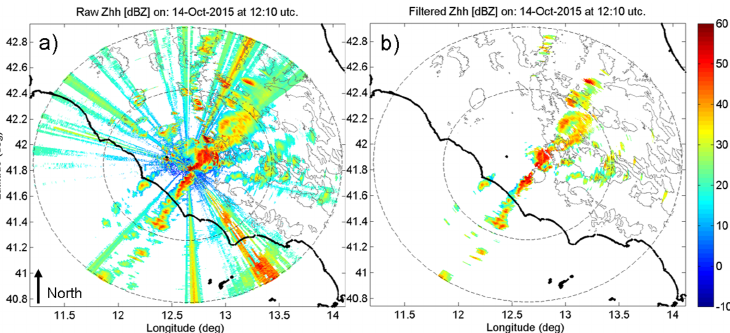
Figure A1. Example of the outcome of the clutter filtering procedure on 14 October 2015 at 12:10 UTC for a Plan Position Indicator (PPI) at 1.59 deg radar antenna elevation. ( a ) Raw reflectivity factor, Z hh , (dBZ); ( b ) filtered version of Z hh after the clutter filtering. Contours of terrain altitudes at 500 and 1500 m asl. (grey contours) and constant range circles at 65 and 120 km from the radar are overlaid.